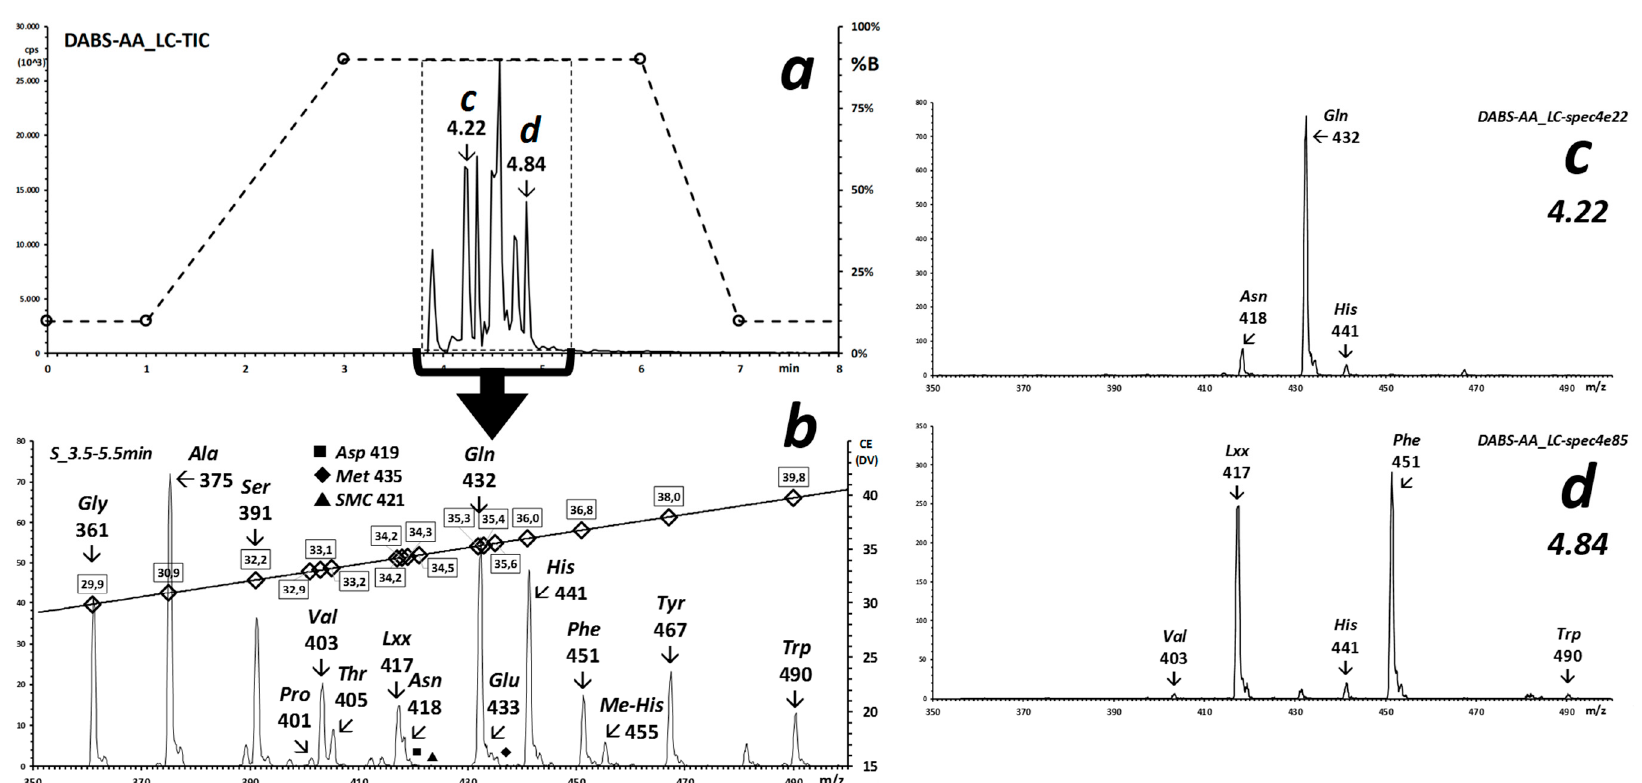
Figure 4. ( a ) XIC of the main deprotonated DABS-AAs detected in a derivatized urine from a healthy laboratory worker. ( b ) Integrated Precursor Ion spectrum of m / z 240 of deprotonated DABS-AAs with m / z from m / z 350 to 500 (negative ions), eluted from the chromatographic column between 3.5 and 5.5 min. ( c , d ) Precursor Ion spectra recorded across the chromatographic peaks eluting at 4.22 and 4.84 min (see panel ( a )), respectively.